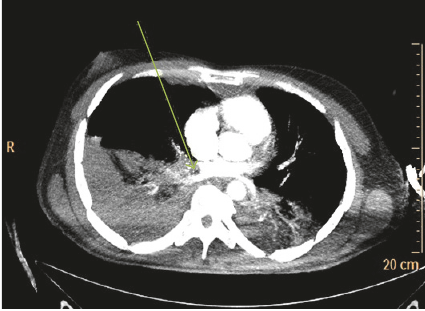
Figure 2: Coronal slice contrast enhanced computed tomography pulmonary angiography. The arrow demonstrates a large filling defect (pulmonary embolus) in the right pulmonary artery with an oligaemic right lung field.